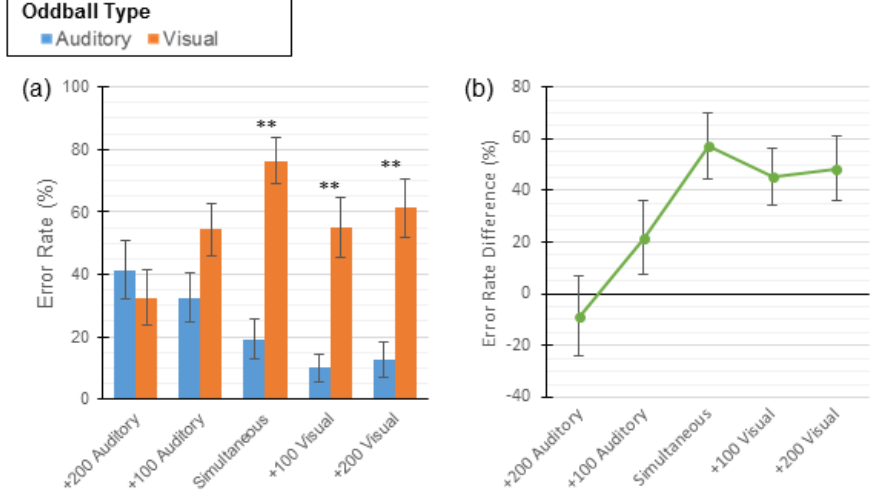
Figure 5. Error analysis for participants in Experiment 2. Three-button task error rates presented across all five conditions. Error bars show ± 1 standard error of the mean (SEM). ( a ) Mean error rates, by oddball type (auditory or visual). ( b ) Mean error difference scores; negative values indicate more auditory errors and positive values indicate more visual errors. ** indicates p < 0.002.